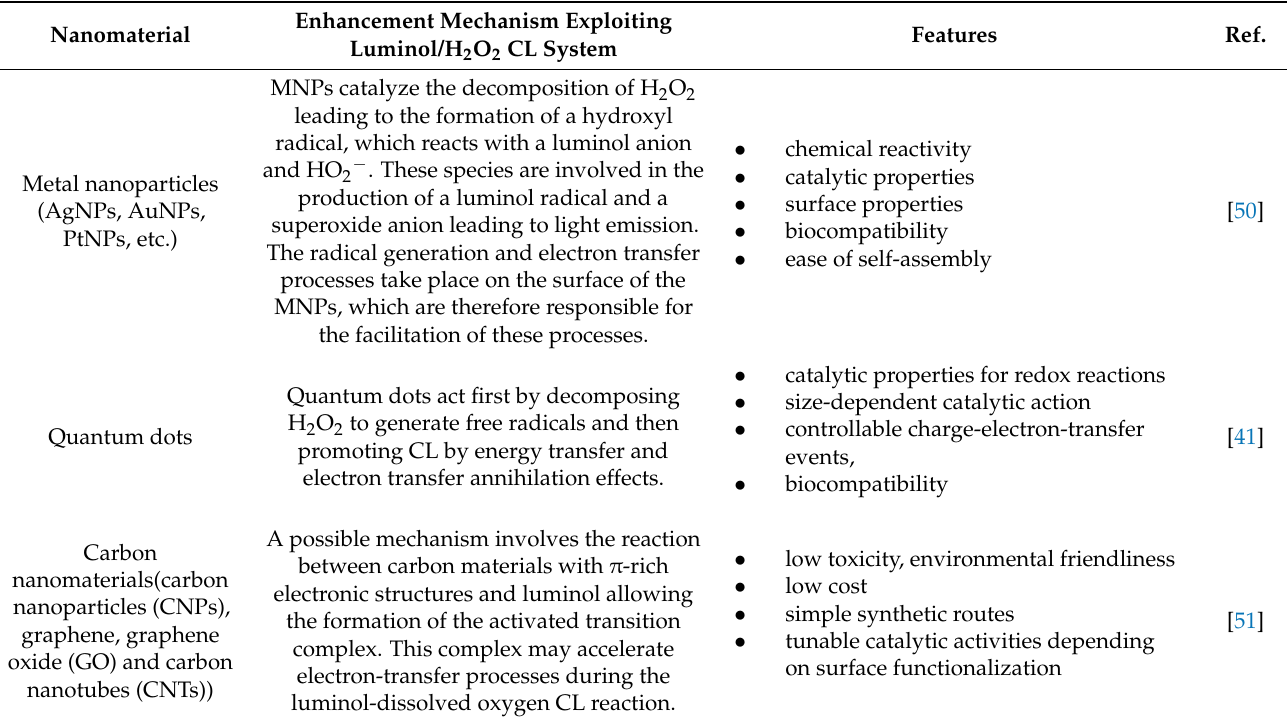
Table 1. Nanomaterials and related mechanism proposed for CL